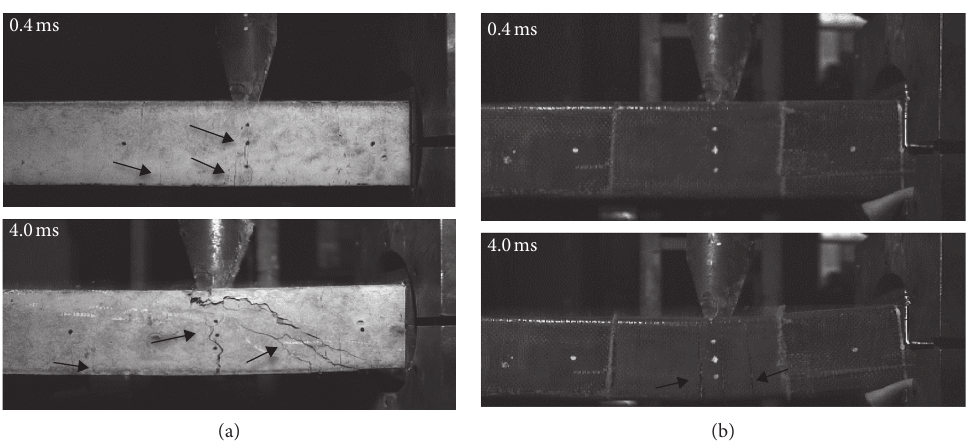
Figure 4: Crack propagation. (a) Unstrengthened specimen. (b) CFRP-shear-strengthened